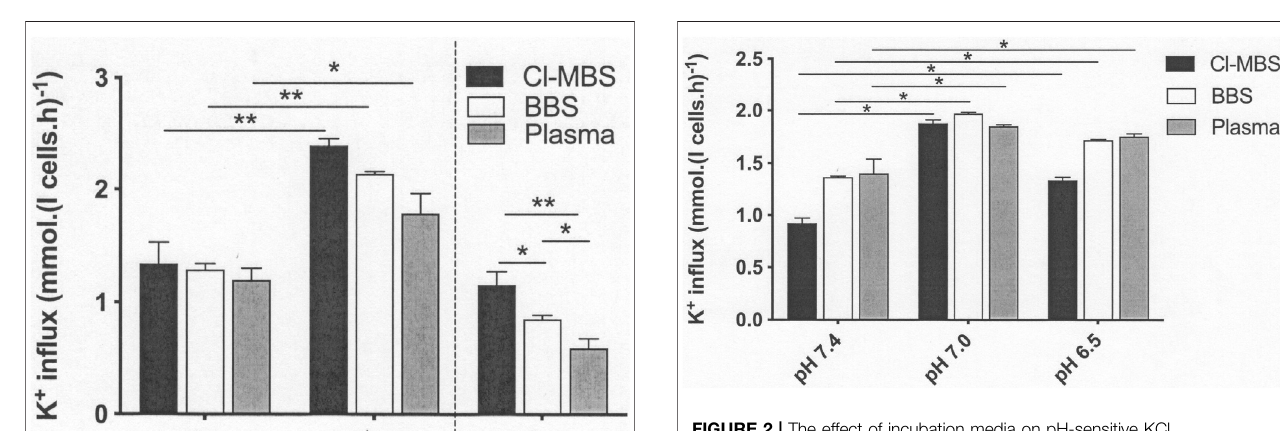
FIGURE 2 | The effect of incubation media on pH-sensitive KCl cotransport activity in LK sheep red cells. Red cells (50% Hct) from LK sheep were equilibrated in Eschweiler tonometers for 15 min at an O 2 tension of 100 mmHg under isotonic conditions (osmolality 290 mOsm.kg − 1 ). The pHs of the incubation media were pH 7.4, pH 7.0 and pH 6.5, adjusted using HNO 3 /NaOHinMBS,butwithCO 2 inthecaseofBBSandplasma(withaCO 2 of 43 mmHg at pH 7.4, 100 mmHg at pH 7.0 and 321 mmHg at pH 6). RBC aliquots were then diluted ten-fold into test tubes pre-equilibrated with the same gas mixtures for measurement of K + in fl ux (extracellular [K + ] of 7.5 mM) over 10 min. All in fl uxes were carried out in the presence of ouabain (100 µM) and bumetanide (10 µM) to inhibit K + in fl ux through the Na + /K + pump and NKCC, respectively. Histograms represent means ± S.E.M., n = 3. p p ≤